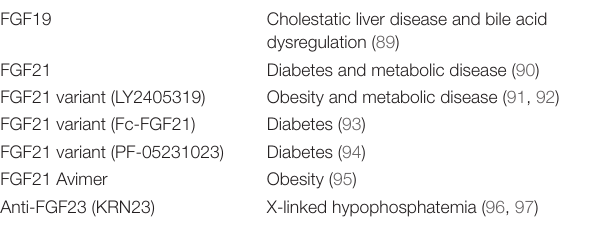
TABLe 3 | Therapeutic utility of endocrine FGFs in humans or